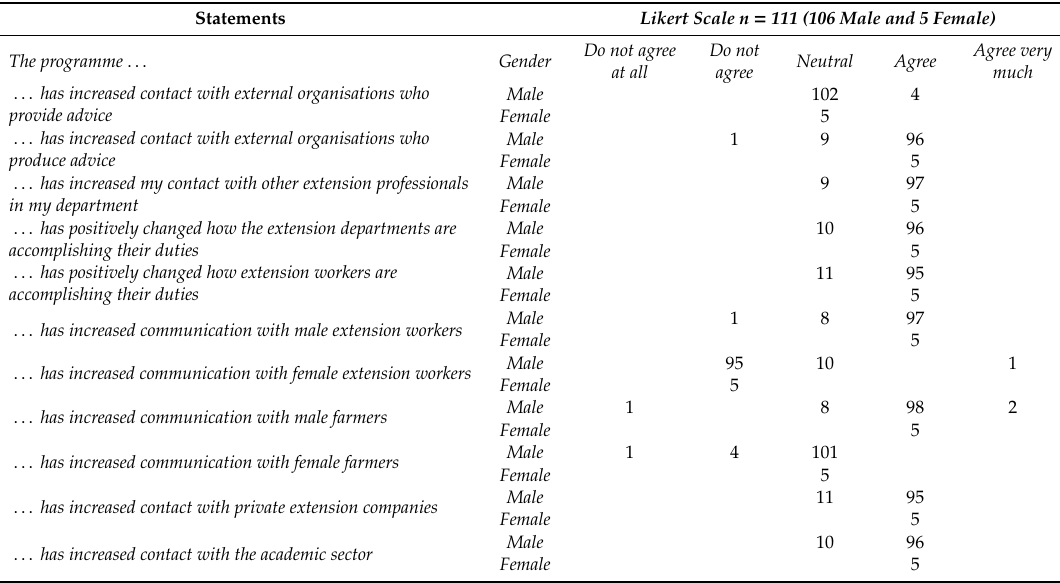
Table 4. Male and female extension worker perceptions of the PW programme. Individual and Institutional Perceptions of PW